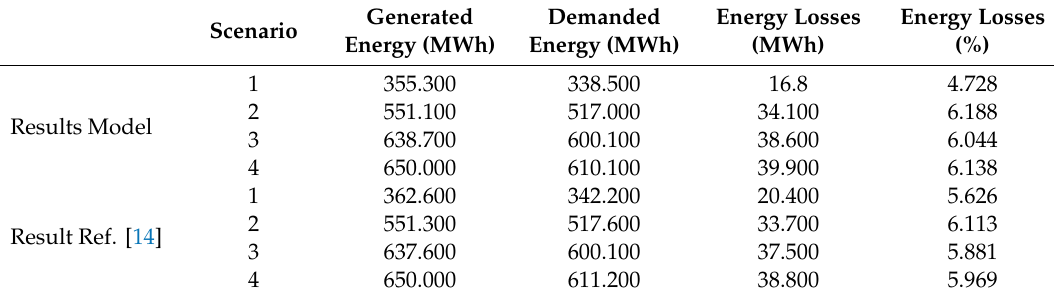
Table 5. Check Results by scenario for generation, demand and losses.